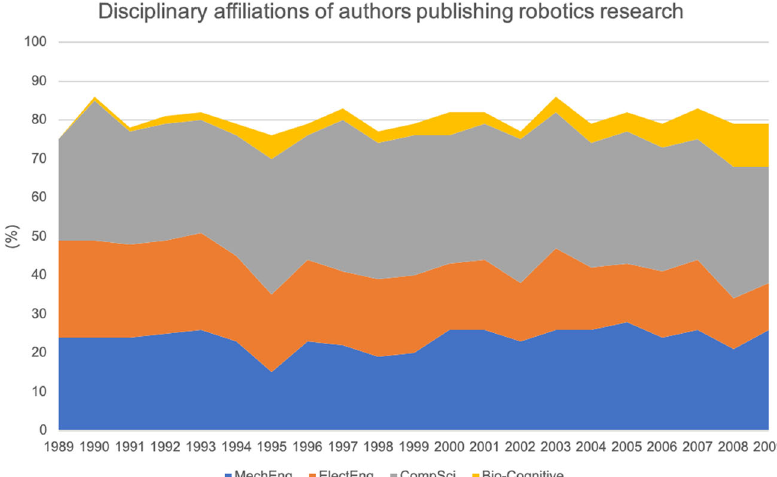
Fig. 1 The distributions of disciplines in academic publications of the top ten robotics journals indexed in Web of Science between 1989 and 2009. The fi gure shows a rise of biological and cognitive sciences in addition to engineering and computer science disciplines underpinning robotics (adapted from Birk, 2011). This fi gure is not covered by the Creative Commons Attribution 4.0 International License. Reproduced with permission of Brik, copyright © Birk, all rights